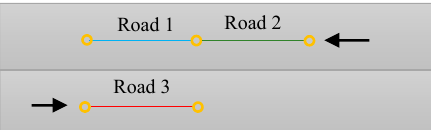
Figure 5. Data-driven traffic forecasting. Using the dynamics of the traffic flow (roads 1, 2, and 3) to capture the spatial dependency using by Diffusion Convolutional Recurrent Neural Network [25].